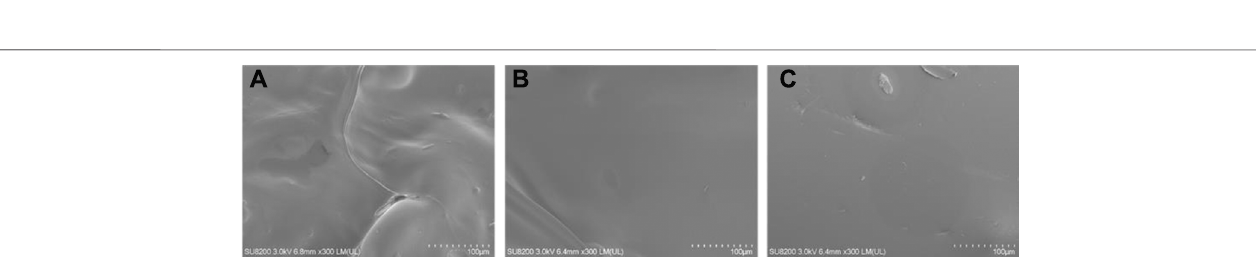
Frontiers in Materials |